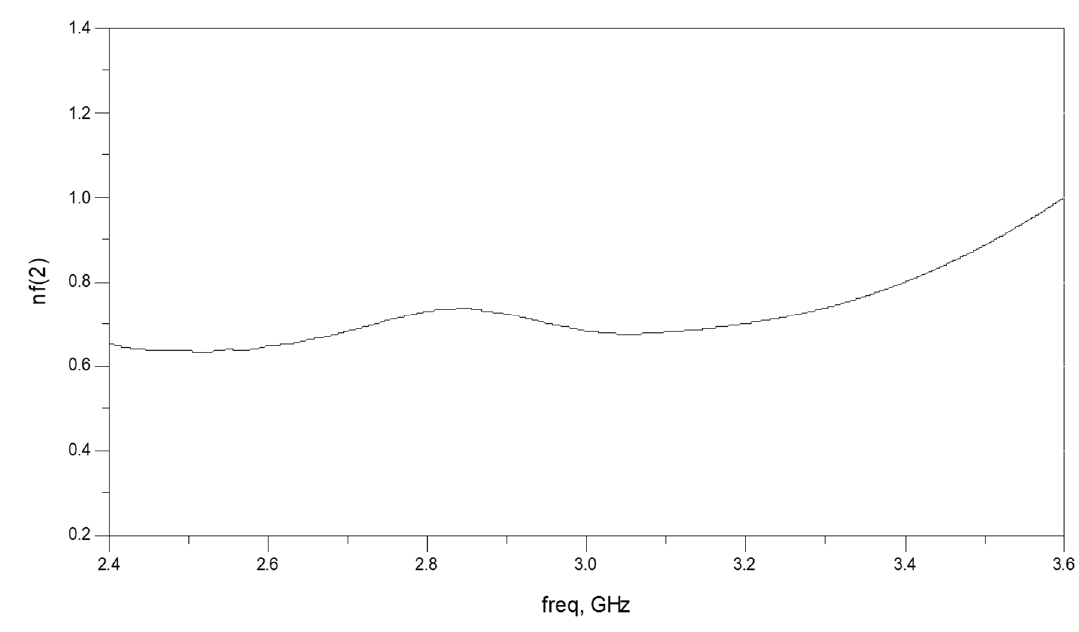
Figure 18. Noise Figure of the Double Layer Active Circular Patch.